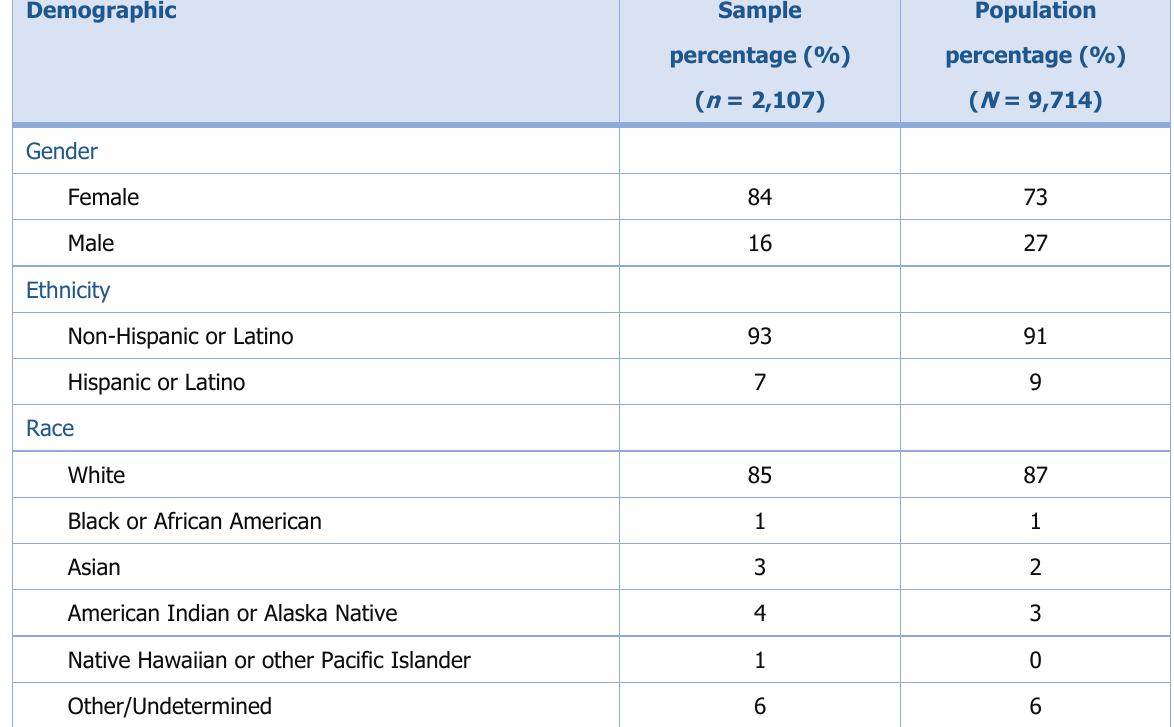
Table 1. Participant Demographics and Relationship to the 4-H Youth Development